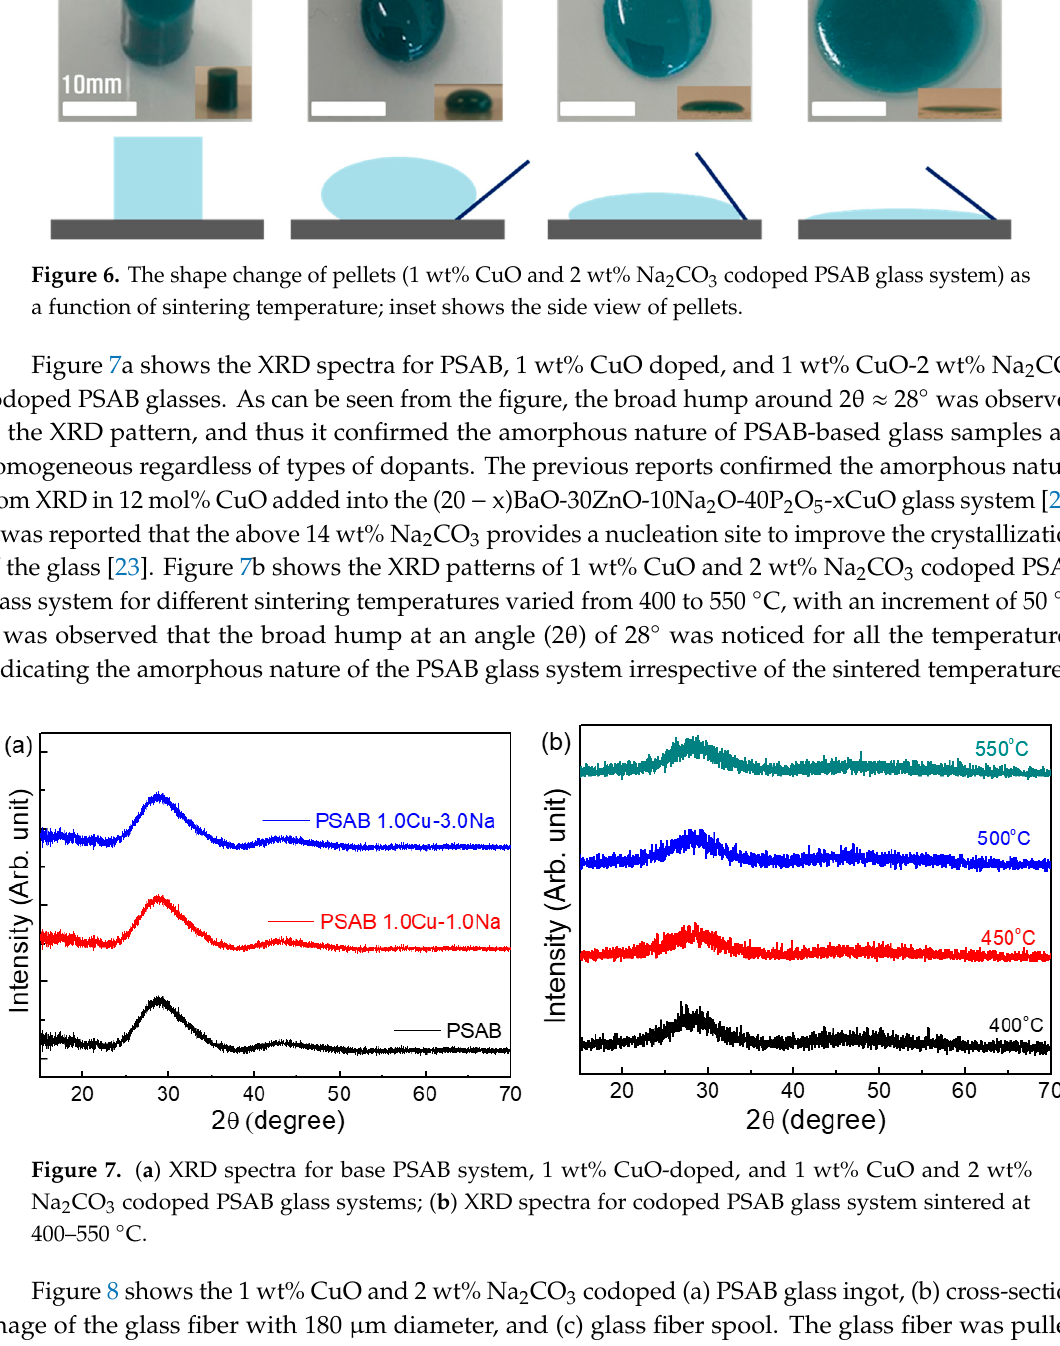
Figure 8. ( a ) Glass ingot; ( b ) microscope image of glass fiber with 180 μ m diameter; and ( c ) glass fiber spool of 1 wt% CuO-2 wt% Na 2 CO 3 codoped PSAB system. In order to optimize the laser sealing process, the microscopic photos of different stages are shown in Figure 9 as a function of sealing cycle and plate temperature. In the reference study [32], Cho et al. reported that screen printed glass frit based on V 2 O 5 and TeO 2 glass had a thickness of ~20 μ m and width of 700 μ m. It was found that the optimized laser sealing conditions were under laser power of 40 W, laser scan velocity of 300 mm/s, and laser scanning cycle of 200. Compared to the above study, two parameters were modified in the present investigation because the fiber type of sealant had a 180 μ m diameter. First, the glass substrates were thermally treated in the temperature range of 130–220 °C for 30 min using hot plates in order to reduce thermal shock after the laser